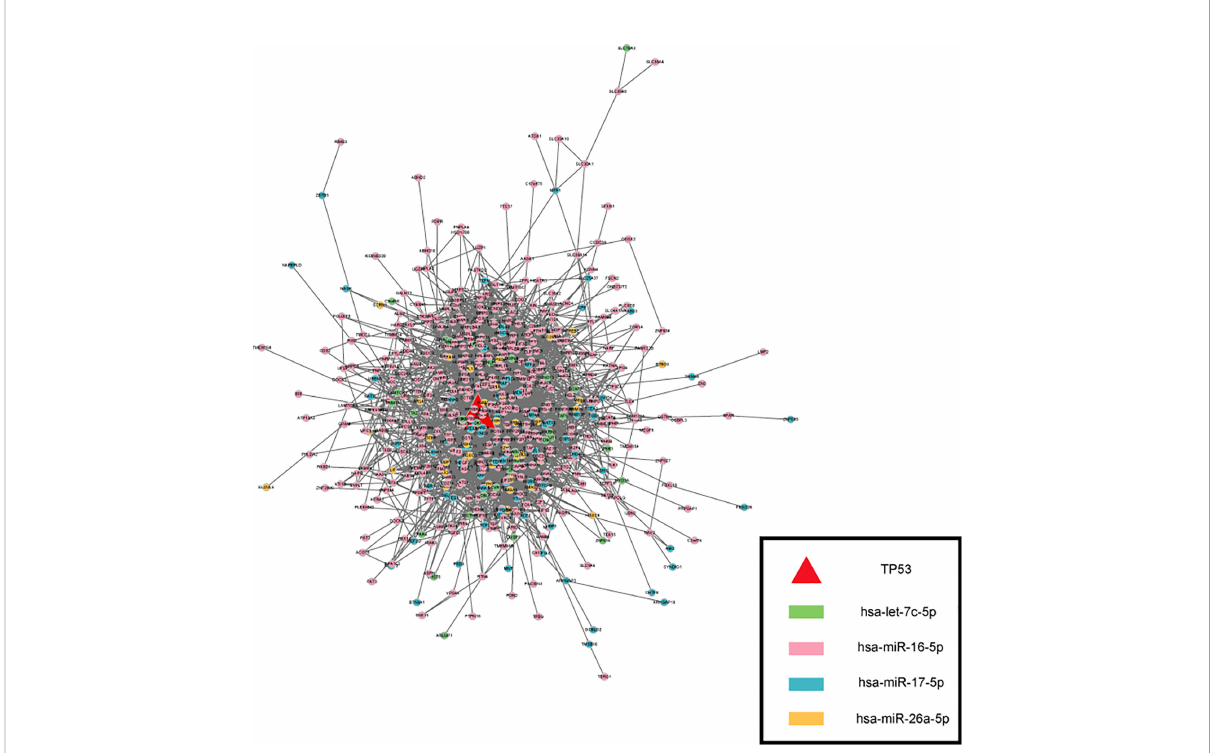
FIGURE 5 The PPI network of targets. The color is drawn according to ser-miRNA, light green, pink, dark green and yellow nodes are the targets of has- let-7c-5p 、 has-miR-16-5p 、 has-miR-17-5p and has-miR-26a-5p